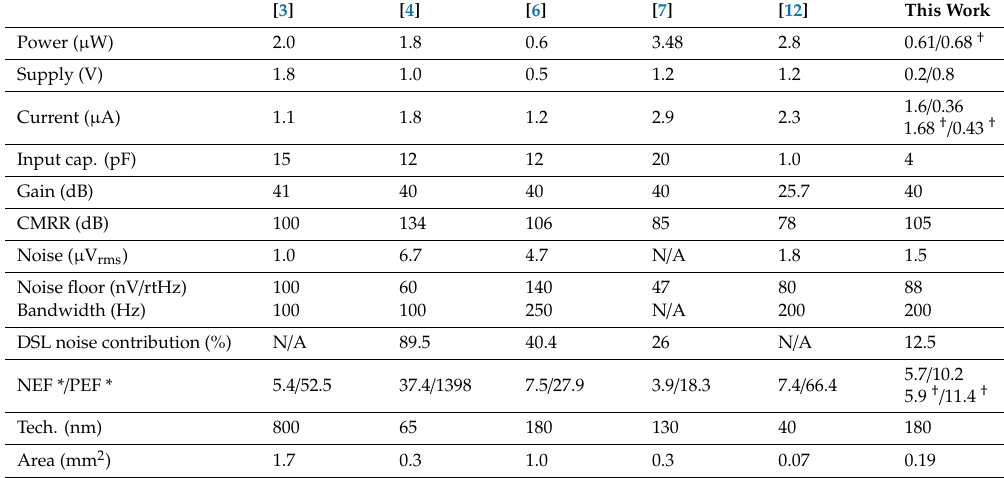
Table 2. Performance summary and